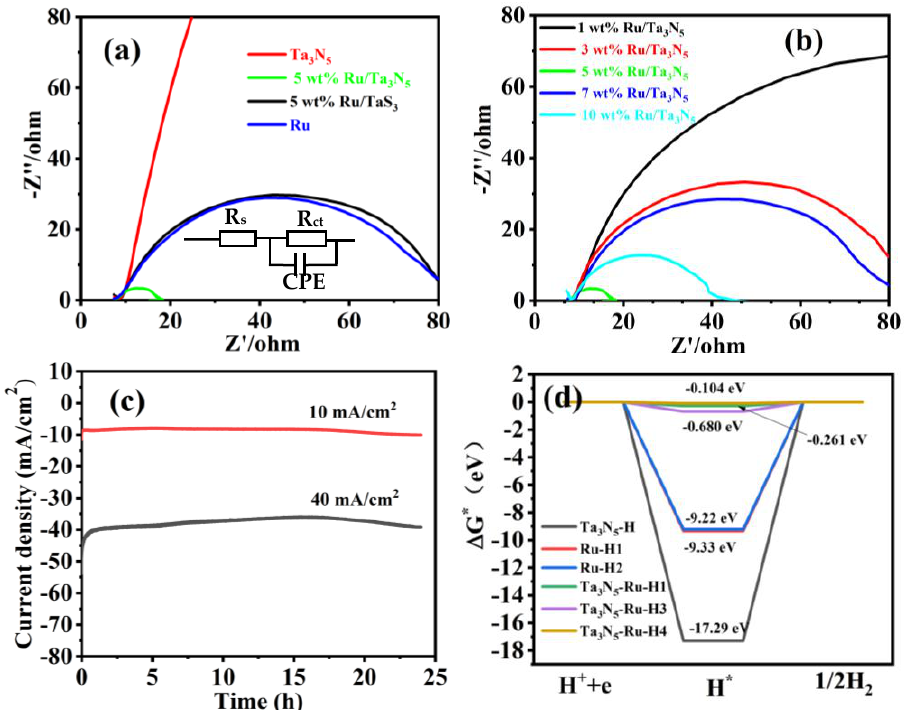
Figure 6. ( a ) EIS curves of 5 wt% Ru/Ta 3 N 5 NBs, Ta 3 N 5 NBs, 5 wt% Ru/TaS 3 NBs, and Ru (5 wt% Ru/C); inset is equivalent circuit. ( b ) EIS curves of 1 wt% , 3 wt%, 5 wt%, 7 wt%, and 10 wt% Ru/Ta 3 N 5 NBs. ( c ) Chronoamperometric curves of 5 wt% Ru/Ta 3 N 5 NBs. ( d ) Hydrogen adsorption free energy (ΔG H* ) on Ta 3 N 5 (H is adsorbed on Ta 3 N 5 : Ta 3 N 5 −H ), Ru (H is adsorbed on different site of Ru: Ru − H1 and Ru − H2), and Ru/Ta 3 N 5 (H is adsorbed on different site of